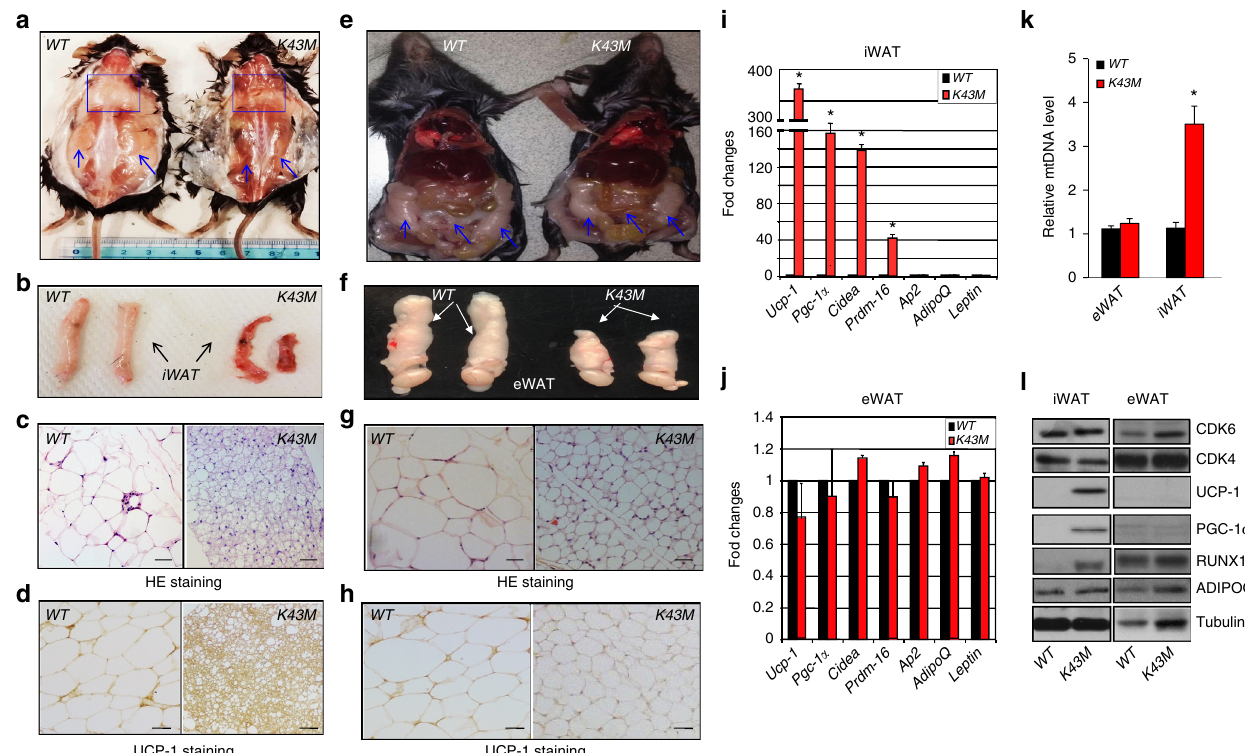
Fig. 2 Loss of CDK6 kinase activity in mice induced white fat browning. a , e Appearance of male posterior-subcutaneous WAT (sWAT) ( a ), and dorsal view of NCD-fed WT and K43M mice ( e ), emphasized with blue squares and arrows. b , f Appearance of a close view of the iWAT ( b ) and eWAT ( f ) from the mice indicated. c , g Representative light microscopic images of H&E-stained sections of iWAT ( n = 6) and eWAT ( n – 6) from male mice indicated (scale bars: 100 μ m). d , h Representative images of UCP-1 immunohistochemical staining ( n = 6) of iWAT and eWAT from mice indicated at 18 weeks of age (scale bars: 100 μ m). i , j Relative mRNA expression levels of BAT-speci fi c markers ( Ucp-1 , Pgc-1 α , Cidea , and Prdm16) and WAT-speci fi c markers ( Ap2 , adiponectin-AdipoQ , and Leptin ) of iWAT ( i ) and eWAT ( j ) tissues from WT and K43M mice. Data shown are mRNA fold change normalized to the control WT , which is arbitrarily set to 1 unit. k Relative expression levels of mtDNA of eWAT and iWAT from WT and K43M mice. Data shown are fold change of mtDNA compared to control. For i and j , * p < 0.05, vs WT ( n = 6), t -test. i Immunoblots of the indicated protein levels in iWAT and eWAT from 50 μ g of cell lysates of WT and K43M mice at 18 weeks of age. α -Tubulin is used as an internal loading control. See also Supplementary Figs. 2 and